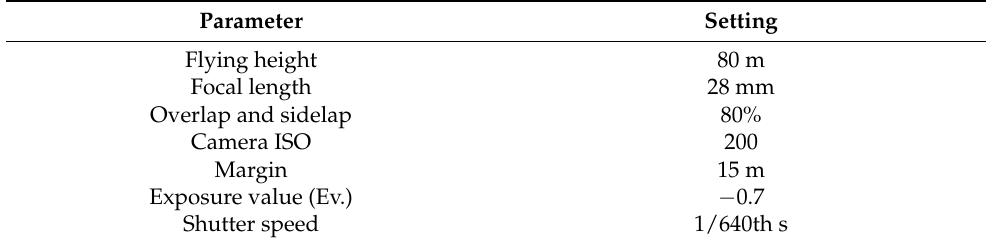
Table 2. Unmanned Aerial Vehicle (UAV) flight parameters used in the photogrammetric data collection campaign. Parameter Setting Flying height 80 m Focal length 28 mm Overlap and sidelap 80% Camera ISO 200 Margin 15 m Exposure value (Ev.) − 0.7 Shutter speed 1/640th